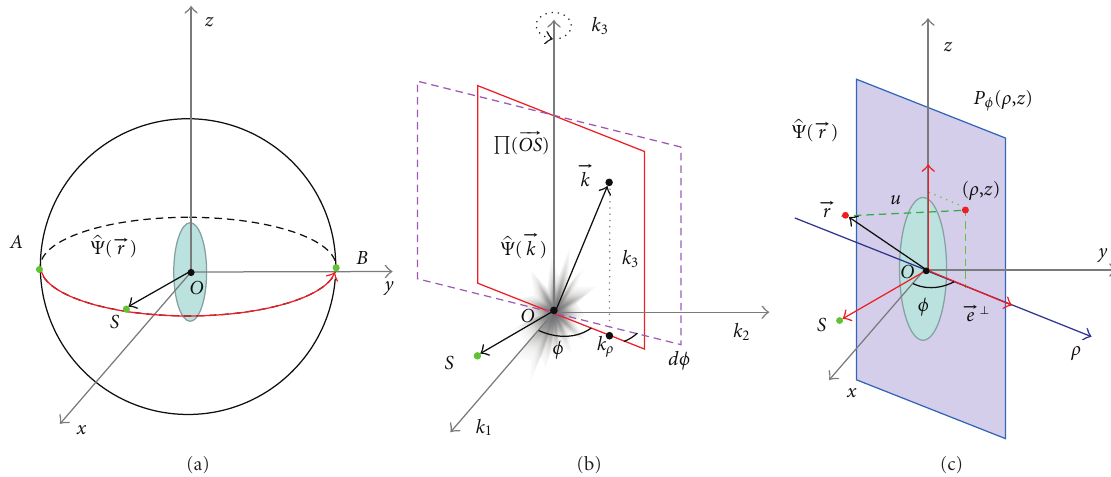
Figure 1: 3D reconstruction problem in parallel-beam geometry and the cylindrical coordinate system. (a) A parallel-beam scans an object along a semicircle locus on the unit sphere; (b) In the frequency domain, when φ 0 increases from 0 to π , the frequency plane φ = φ 0 scans every point exactly once except for the points on the k 3 axis, and the end point of the normal vector (0, − 1,0) to (0,1,0); (c) For simplicity, we suppose that the detector panel passes through the